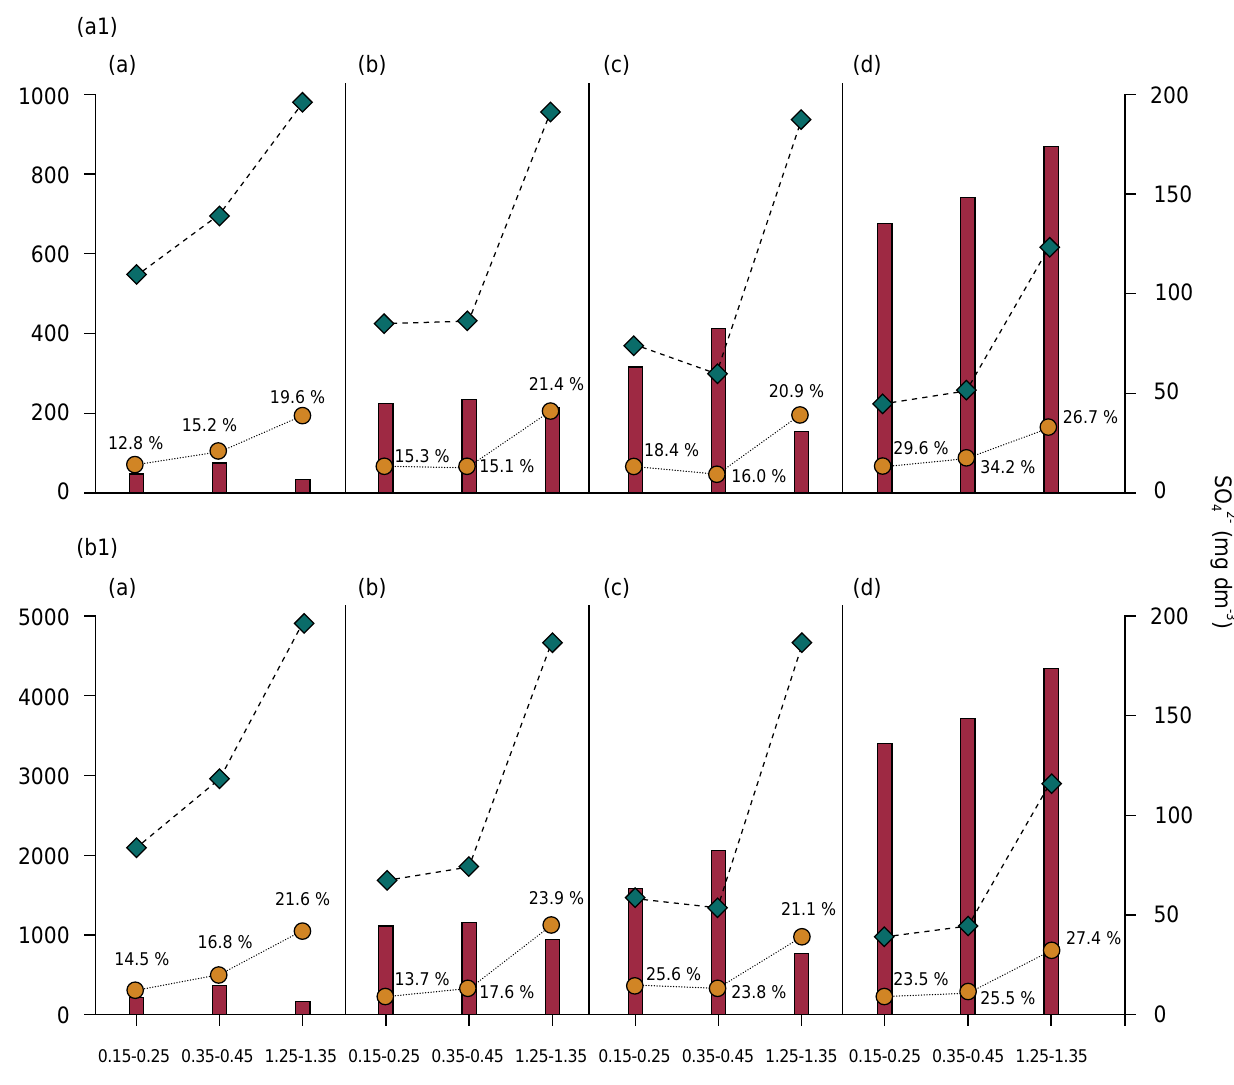
Figure 3. Adsorbed and desorbed amounts of selenate (SeO 42- ) at different soil layers of a Latossolo Vermelho distrófico (Oxisol). The percentages shown above the desorption points refer to the desorbed percentages as a function of the adsorbed amount. The letters (a), (b), (c), and (d) correspond respectively to the rates of phosphogypsum applied to the soil, as follows: 0, 7, 14, and 56 t ha -1 . (a1) and (b1) refer to SeO 4 2- doses of 100 and 500 μg L -1 ,